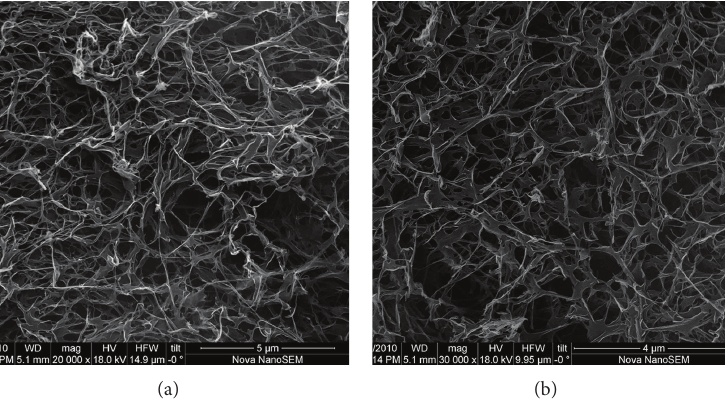
Figure 3: Scanning Electron Microscopy images of peptide amphiphile (PA) gel with Ankaferd (a) or alone (b) at pH 10.